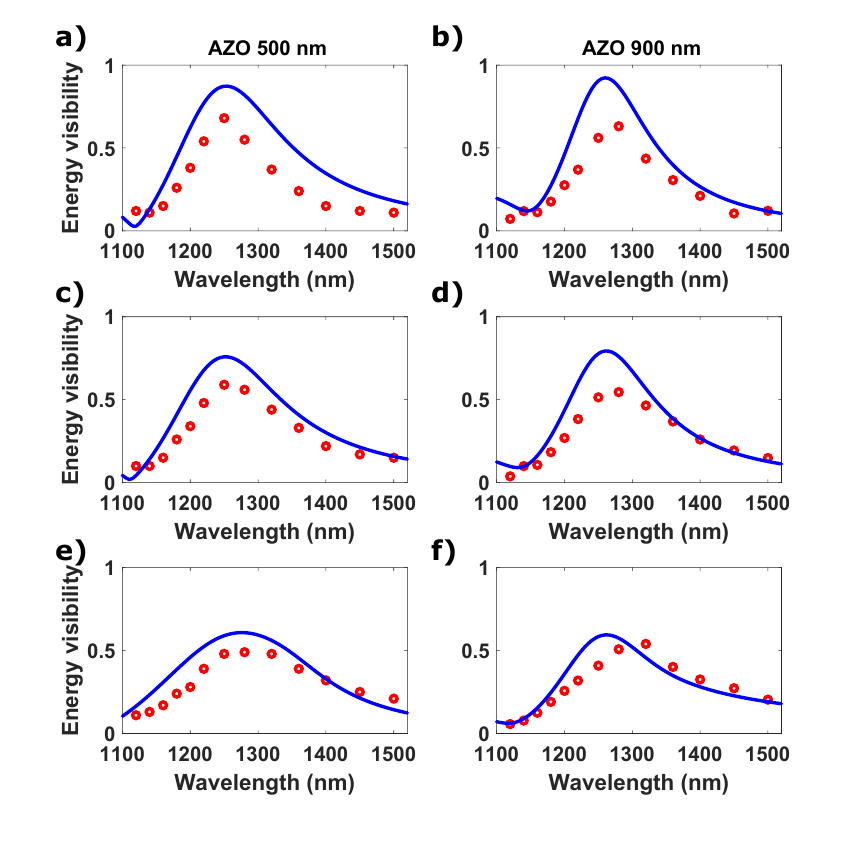
Figure 4. Experimental (circles) and transfer matrix method (TMM) simulation (solid line) of normalized visibility of the total energy for aluminum-doped zinc oxide (AZO) 500 nm and 900 nm with different values of k . ( a , b ) High losses k 1 , ( c , d ) middle losses k 2 and ( e , f ) low losses k 3 . For the TMM simulation we suppose ∆ λ ∼ 60